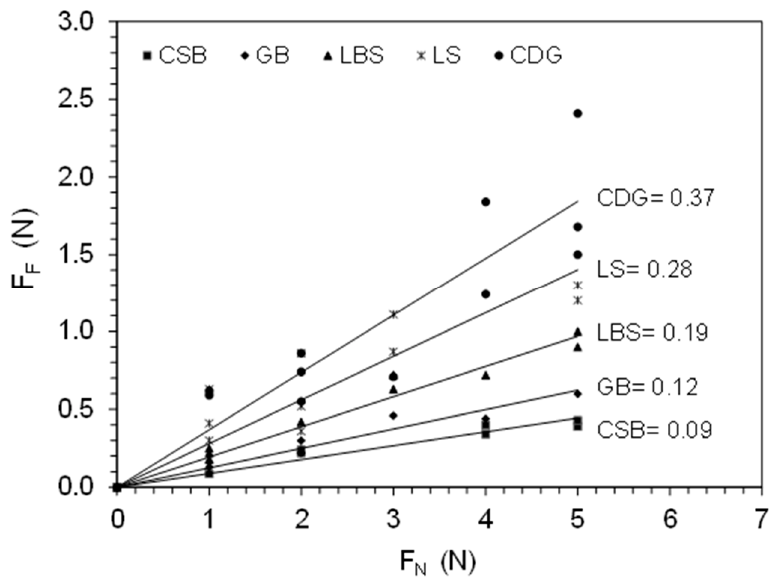
Figure 4. Variation of frictional force with normal force for the materials tested and corresponding inter-particle coefficients of friction.